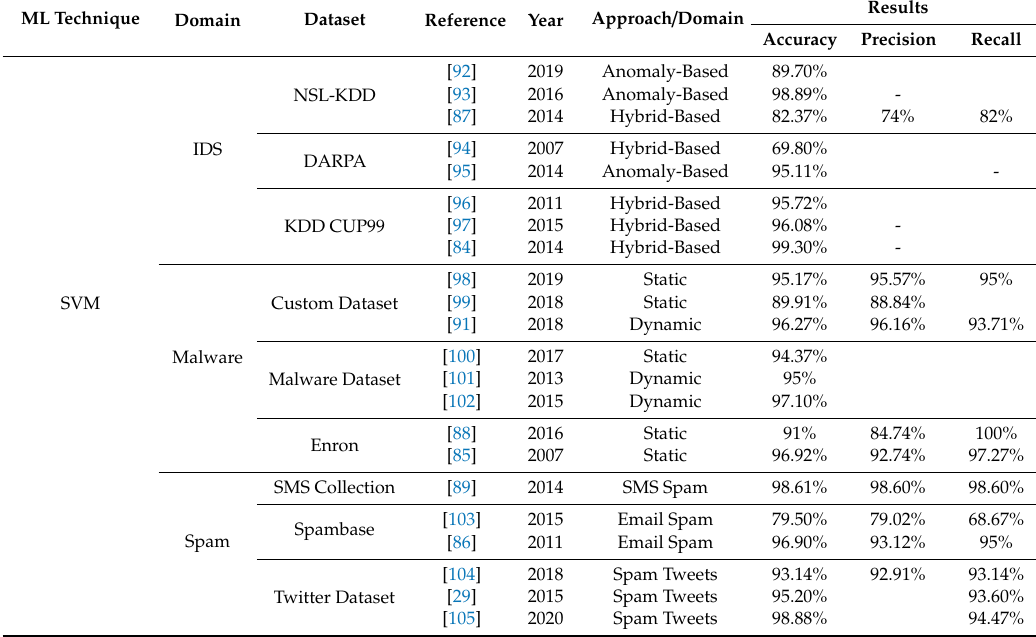
Table 4. Evaluation of SVM in